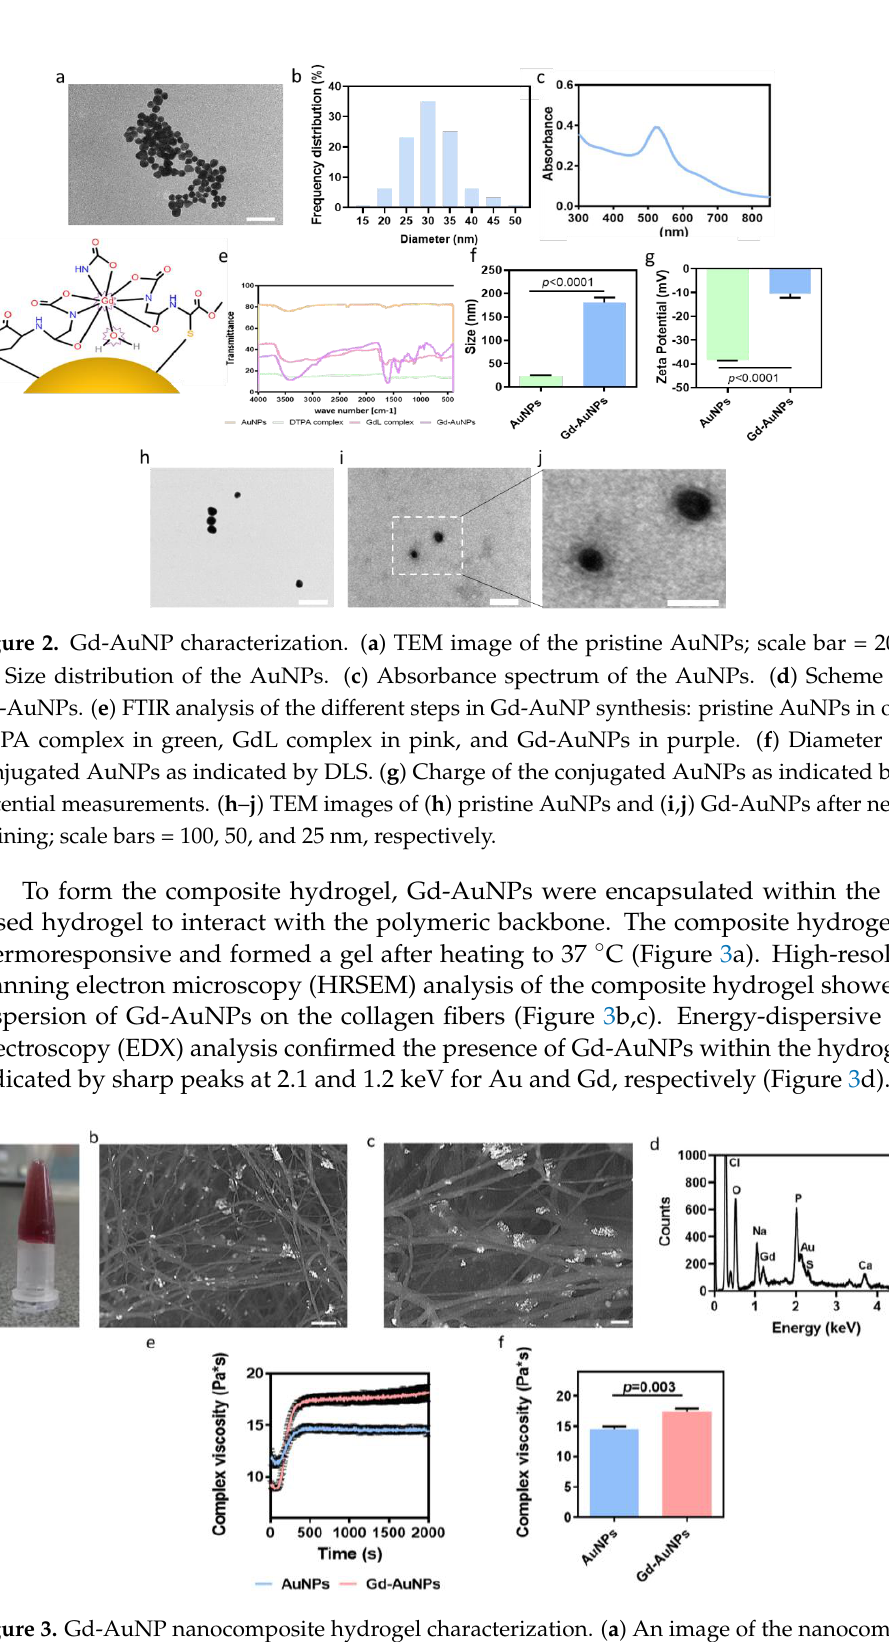
Figure 3. Gd-AuNP nanocomposite hydrogel characterization. ( a ) An image of the nanocomposite hydrogel after gelation at 37 ◦ C. ( b , c ) HRSEM images of the nanocomposite hydrogel. The NPs appear in white. Scale bars ( b ) = 1 µ m, ( c ) = 300 nm. ( d ) EDX analysis of the composite hydrogel. ( e , f ) Rheological properties of the composite hydrogel over time ( e ) and 15 min post gelation in 37 ◦ C ( f